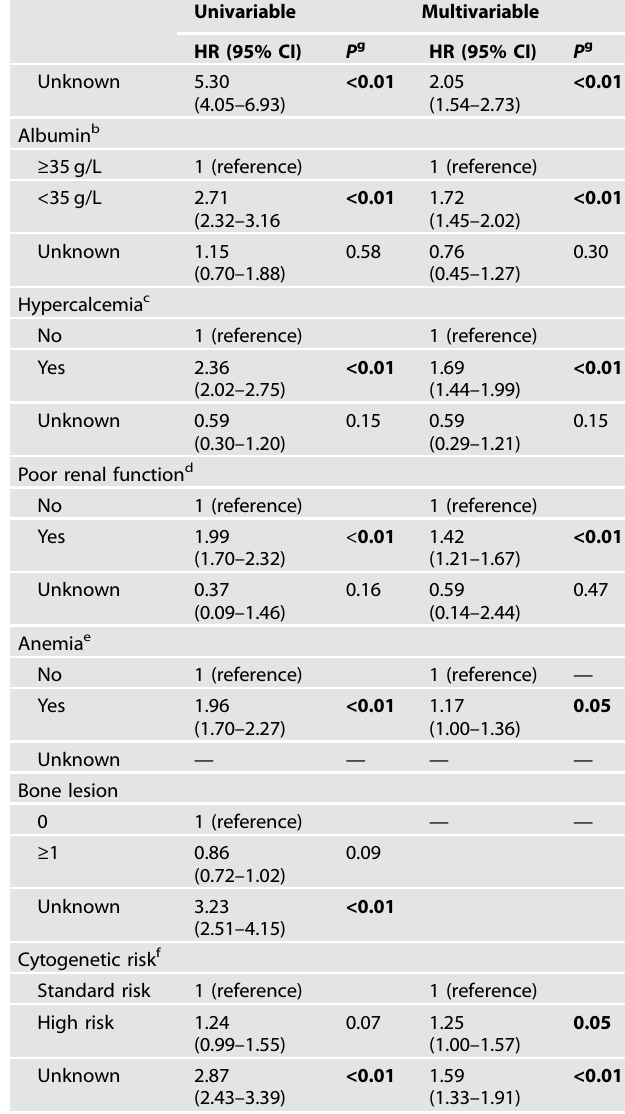
Table 2. Impact of various diagnostic parameters on risk of EM for patients with newly diagnosed MM diagnosed in 2014 –